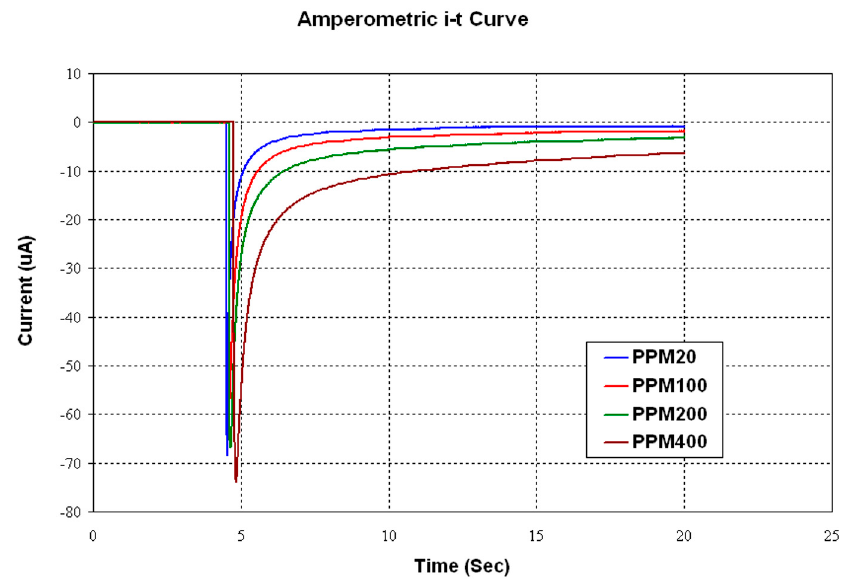
Figure 20. Amperometricuric acid sensor output current vs. time.